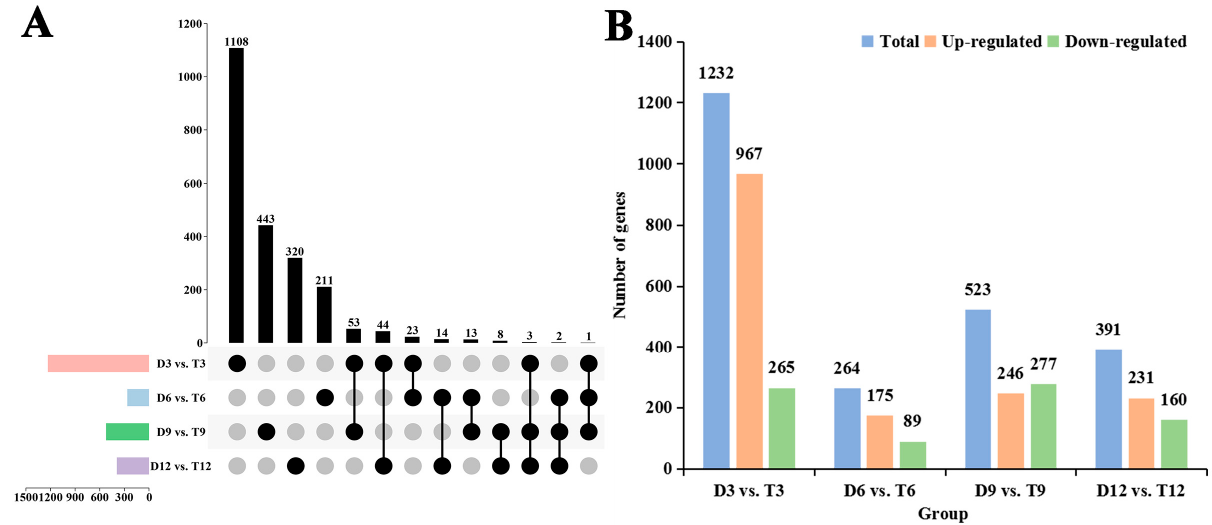
Figure 4. Statistics of DEGs in the diploids and tetraploids. ( A ) Upset diagram of DEGs in different comparison groups. ( B ) Statistical analysis of up-regulated and down-regulated DEGs in different comparison groups.